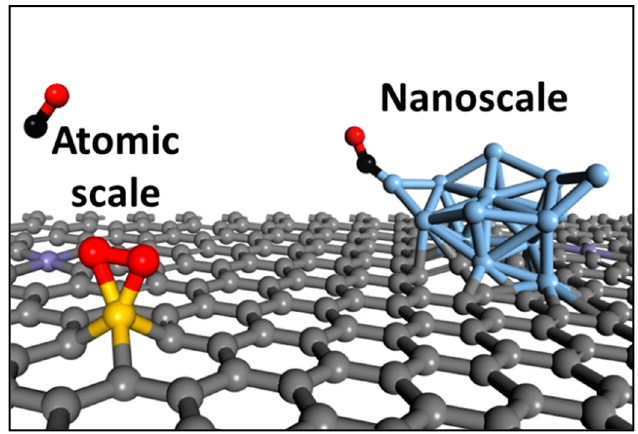
Figure 2. Sketch of graphene-supported nanoscale and atomic-scale catalysts. Color Scheme: Graphene in grey; embedded single-atom catalyst in yellow; supported nano catalyst in blue.